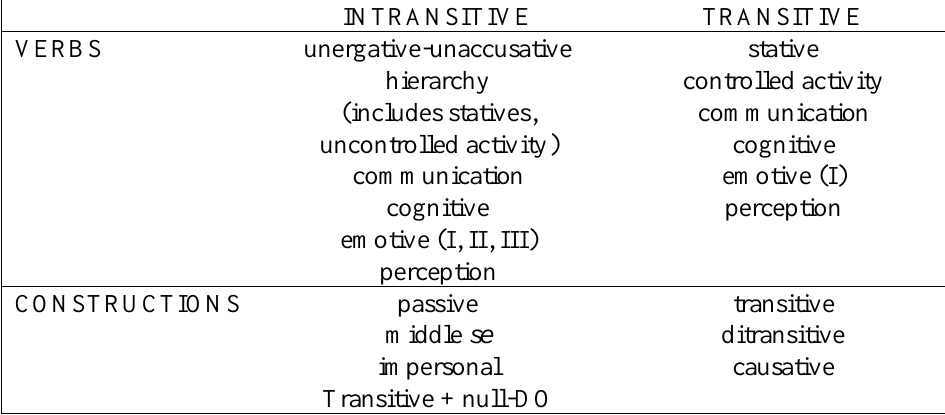
Figure 4 . Distribution of past verbal forms within intransitive constructions, and in constructions with an affected subject